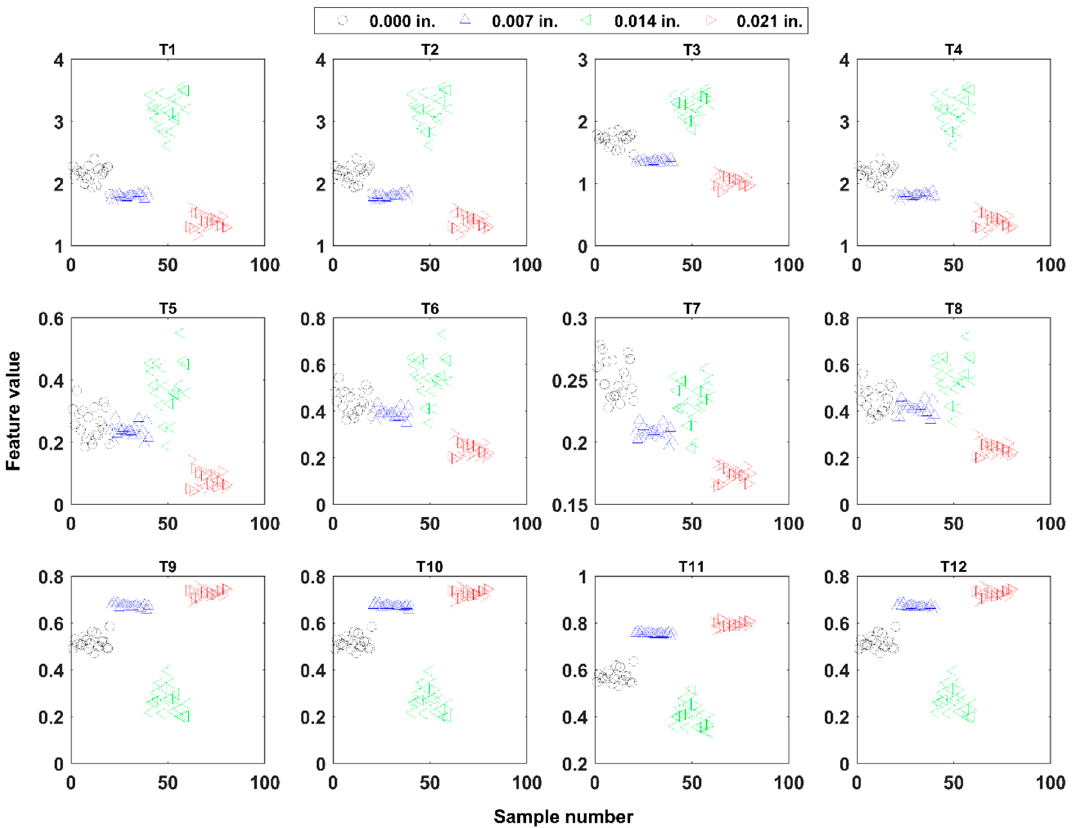
Figure 12. Values of 12 features of samples in Test 1.